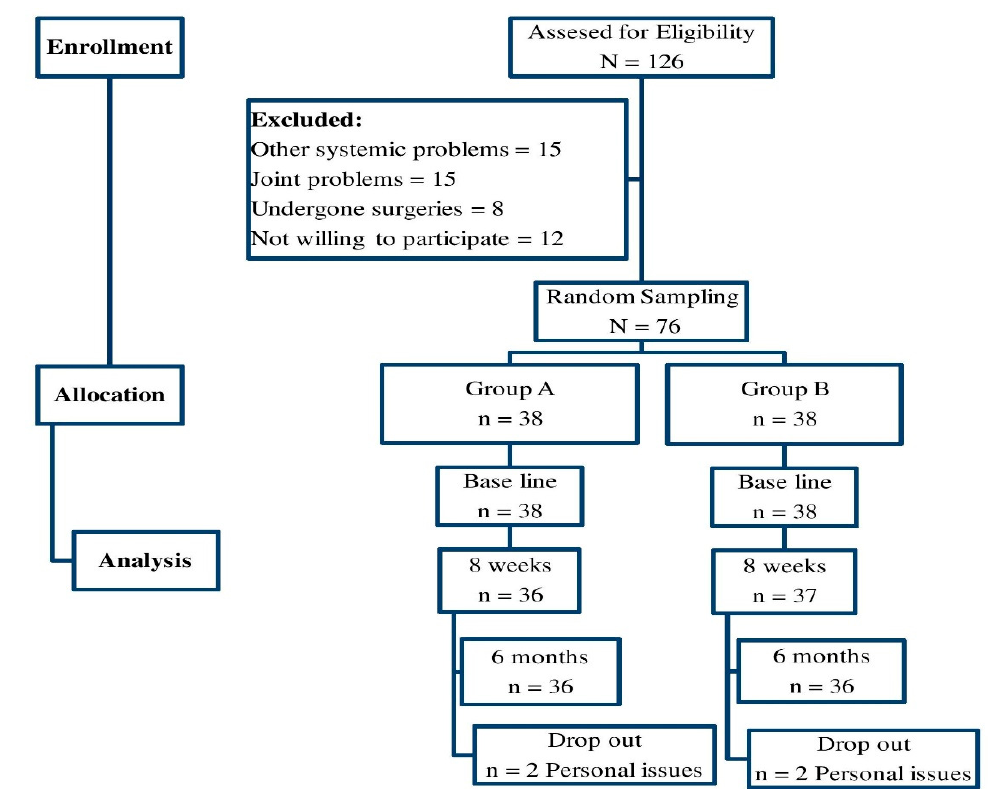
Figure 1. Flow chart showing the study details.